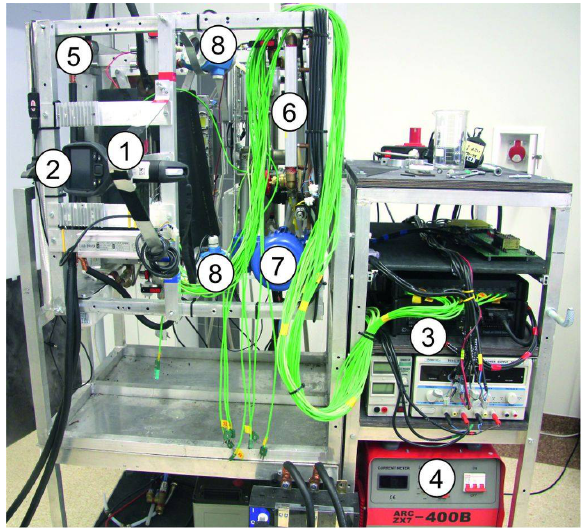
Fig. 1. The image of the main systems of the experimental setup, 1-test section; 2-infrared camera, 3-data acquisition station, 4-inverter welder, 5-shunt, 6-mass flowmeter, 7- gear pump, 8- pressure sensor.